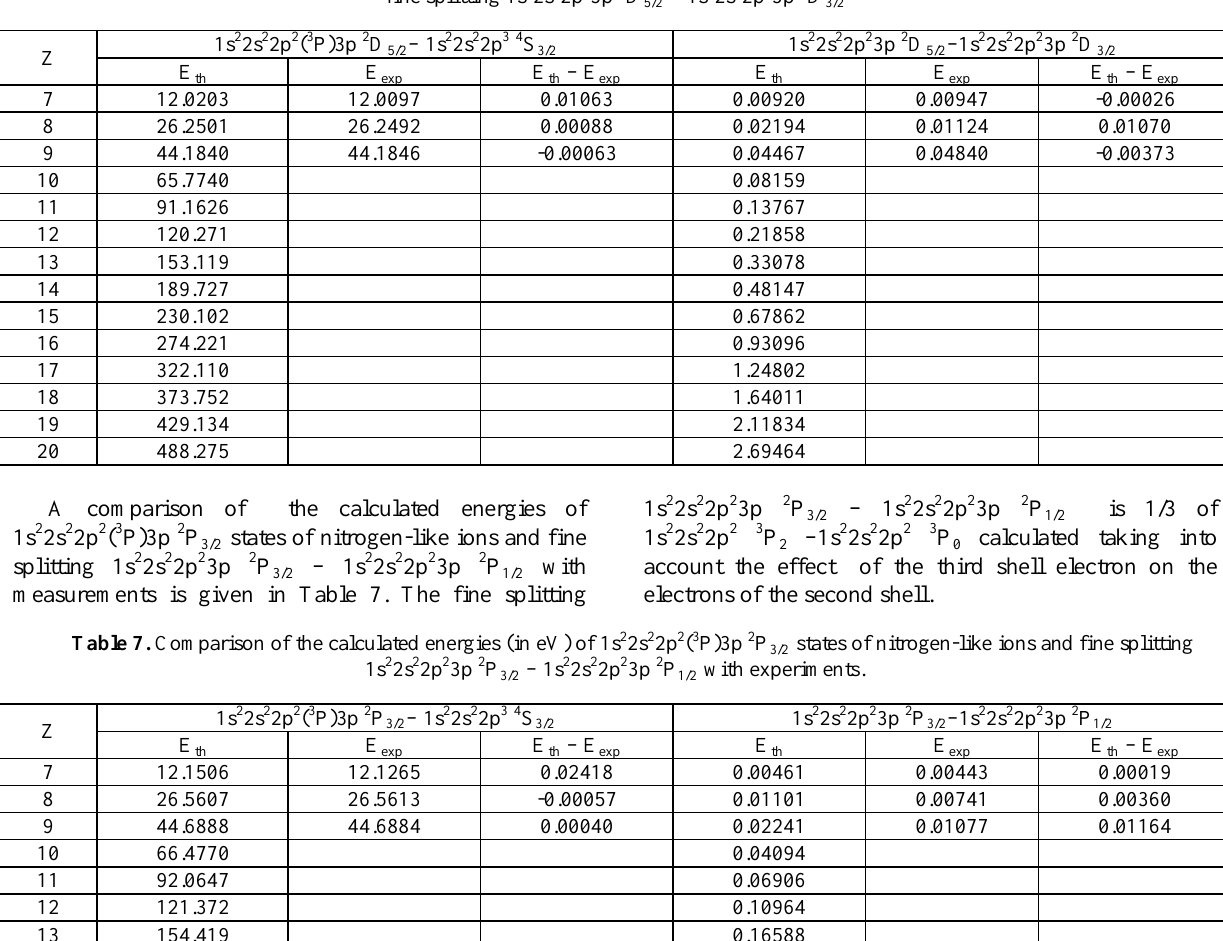
Table 6. Comparison with experiments of the calculated energies (in eV) of 1s 2 2s 2 2p 2 ( 3 P)3p 2 D 5/2 states of nitrogen-like ions and